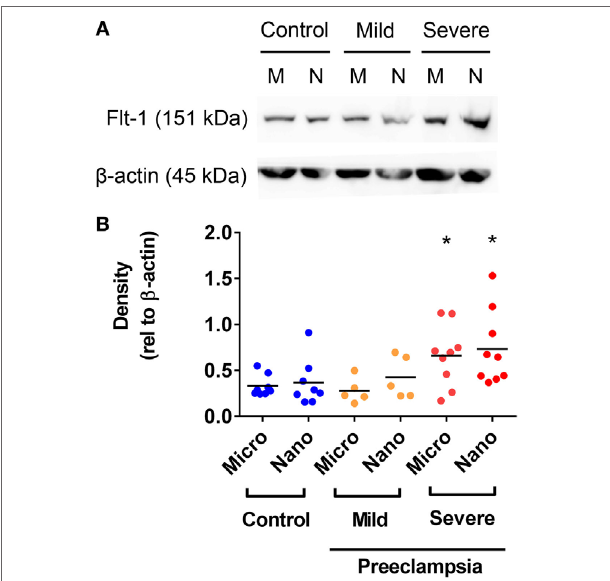
FigUre 3 | Levels of Flt-1 carried by EVs extruded from first trimester and term placentae. Total protein was extracted from macro-, micro-, and nano-vesicles collected from six first trimester and six term placentae. The presence of Flt-1 was detected by western blotting (a) and the levels of Flt-1 were semi-quantified relative to β -actin by densitometric analysis (B) . The mean value in each group is indicated (* p < 0.05, ** p < 0.01, **** p < 0.0001, unpaired t